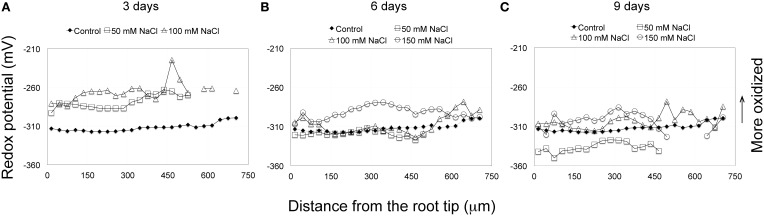
(A–C) Redox profiles of Arabidopsis primary roots, grown on solid medium, and treated for extended periods (3–9 days) with various concentrations of NaCl (50–150 mM). After 6 days treatment with 50 mM NaCl the redox profile more or less matches the redox values and profiles of the control, whereas by day 9 the overall redox status of 50 mM salt-treated roots has become more reduced than the control. Except for the terminal 180 μm, the redox profile of 100 mM salt-treated roots matches the control, but by day 9 becomes, overall, more oxidized. The redox profiles of roots treated continuously with 150 mM NaCl, in general, remain at values more positive (more oxidized) than the control. The control curve (solid squares) is obtained as described in Figure 1. Each salt treatment redox profile curve represents an average from eight roots, for which the standard deviations are shown in Supplementary Figure 3.